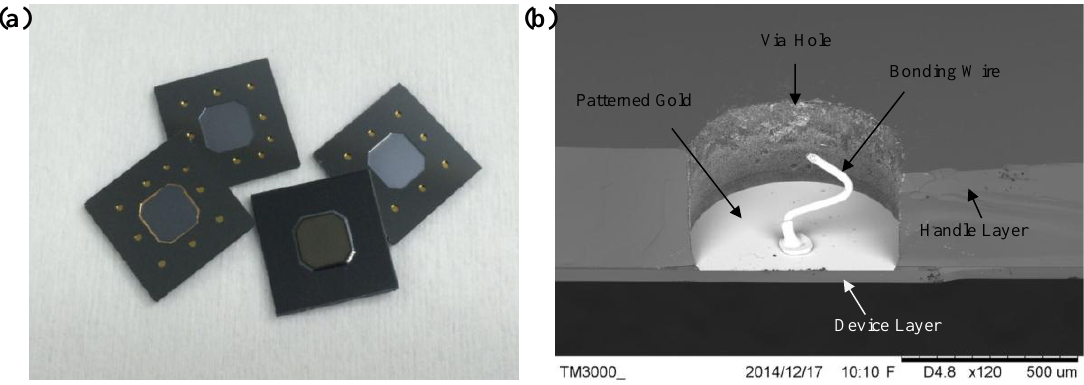
Figure 5. ( a ) A picture of the micro-fabricated devices; ( b ) A SEM picture of a via hole after wire bonding, where the gold portion on the handle layer was thoroughly removed with the gold portion left on the device layer for wire